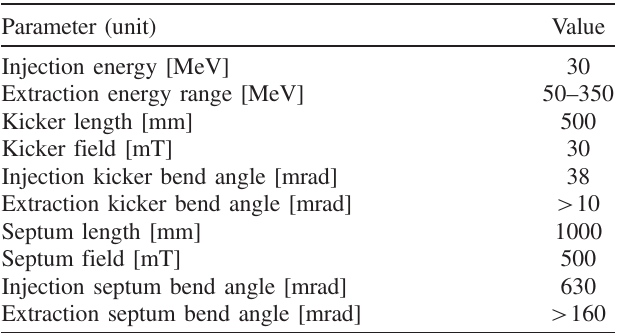
TABLE VI. NORMA injection and extraction